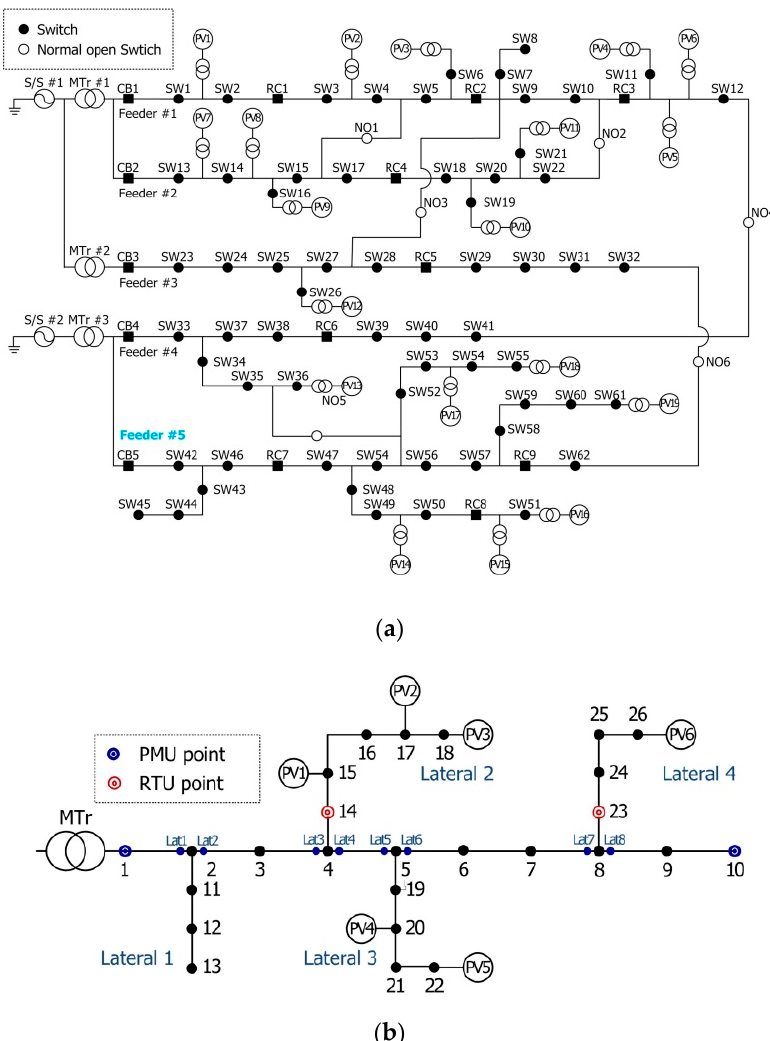
Figure 8. Test system for the case studies. ( a ) Test model of the Korea active distribution test system (KADTS). ( b ) Modified test system.